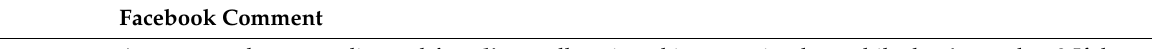
Table 6. Tweet stigmatizing COVID-19 patients from certain occupations (N =